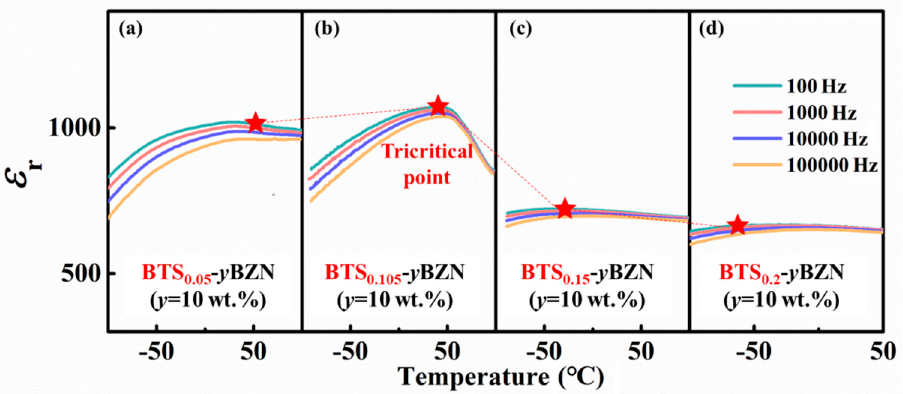
Figure 4. Temperature-dependence of dielectric permittivity for BTS x - y BZN ( y = 10 wt %) ( a ) x = 0.05; ( b ) x = 0.105; ( c ) x = 0.15; ( d ) x = 0.2 at different testing frequencies ( f = 10 2 , 10 3 , 10 4 , 10 5 Hz). x = 0.105 shows the maximum peak value, indicating the tricritical behavior for this composition.